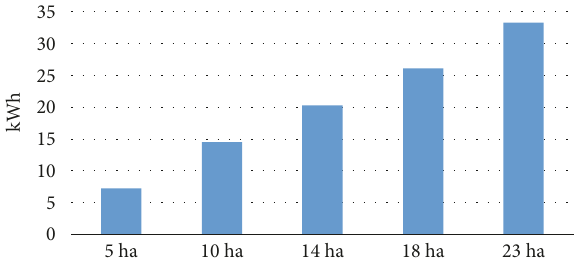
Figure 9: Projected load variations at increments in land area.